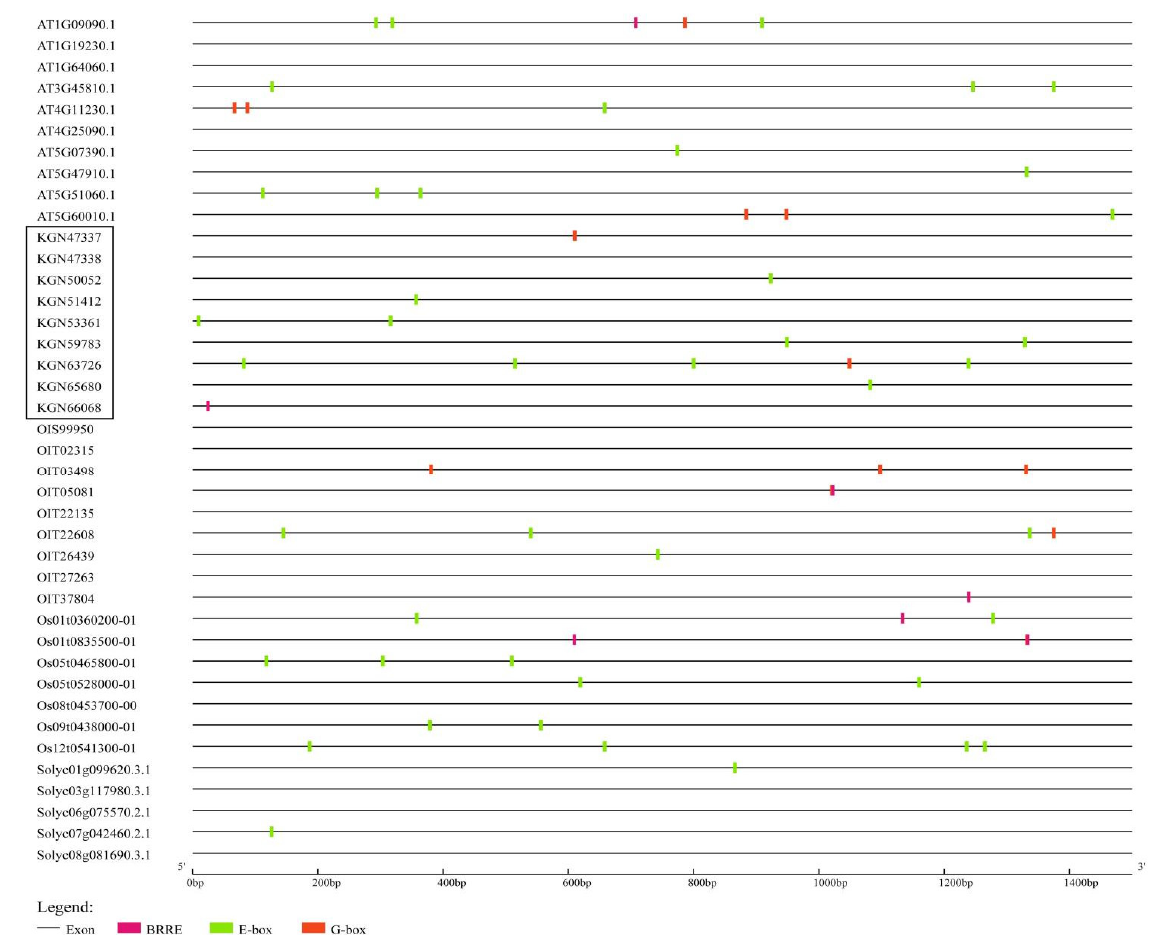
Figure 2. Analysis of BZR-binding sites in the 1500-bp DNA sequences upstream of the promoter of RBOH in different plant species ( Arabidopsis , cucumber, rice, tobacco, and tomato). The black line represents the exons, the two red modules represent different inhibition sites (BRRE and G-box), and the green module represents the activation sites (E-box).